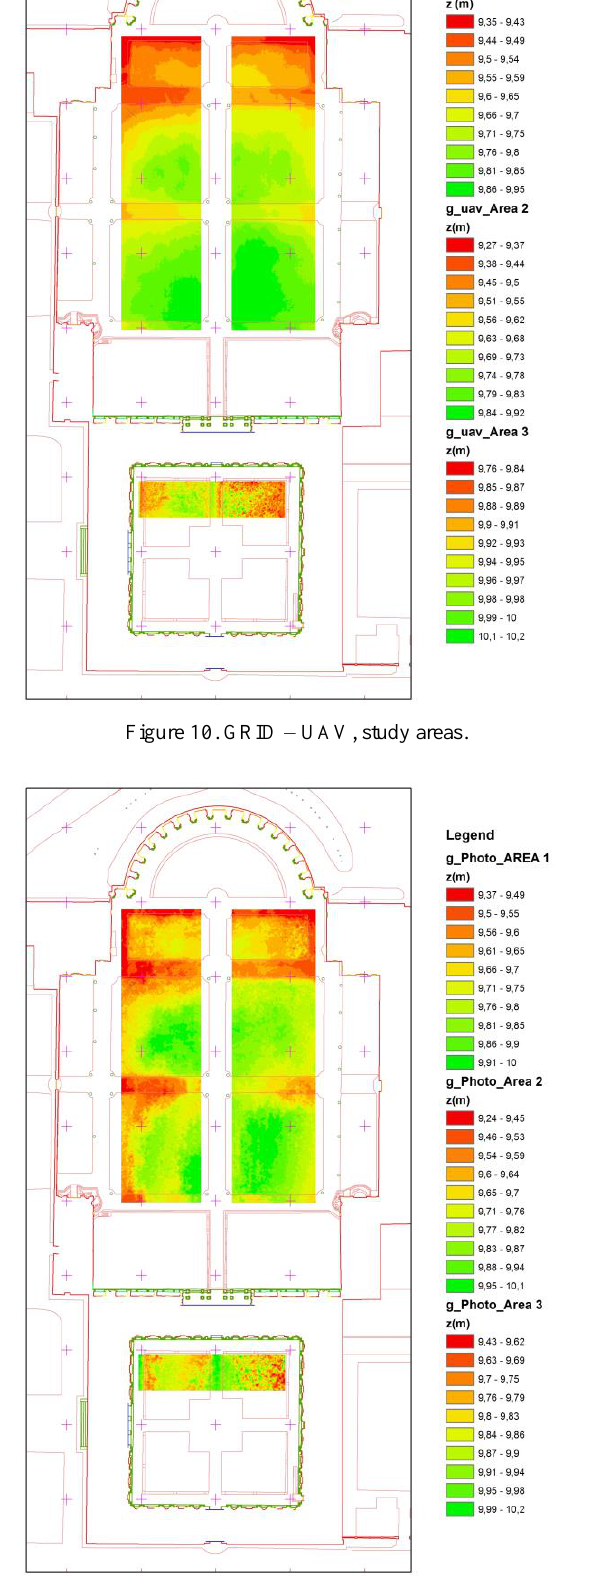
Figure 11. GRID – Aerial Photogrammetry, study areas.